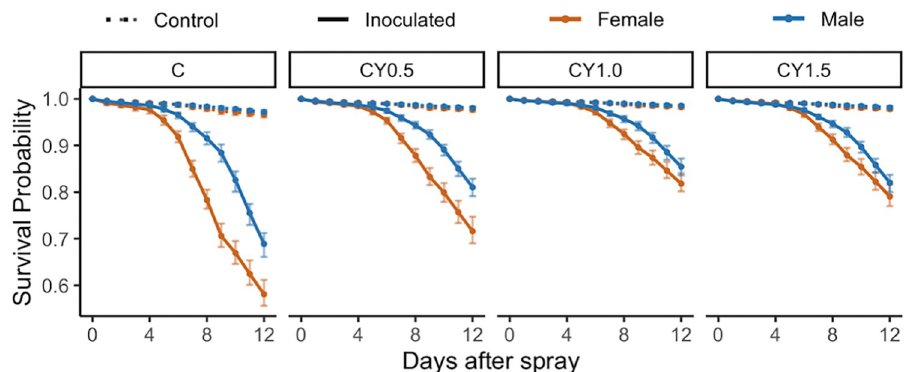
Fig 6. Level of yeast supplementation affects sexual dimorphism in survival when D . melanogaster are inoculated with B . bassiana GHA (Experiment 5). All flies were reared on cornmeal diets. After the sprays, flies received cornmeal diets supplemented with varying levels of yeast. See S7 and S8 Tables for statistical analysis of these results. The figure shows model estimates and 95% confidence intervals for the raw data shown in S15 Table.